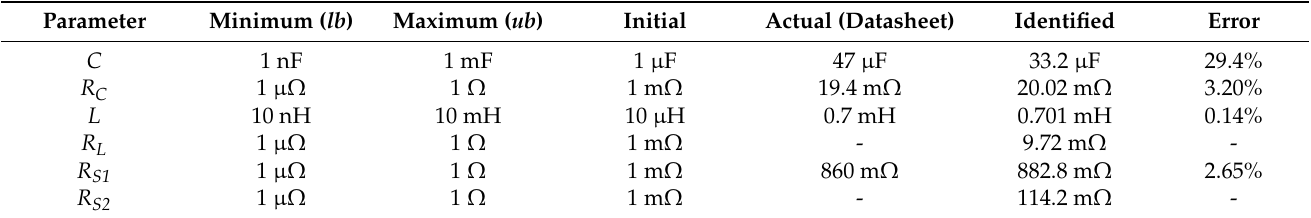
Table 4. Optimization conditions of the NLS identification algorithm of the boost converter and comparison of actual and identified parameters.